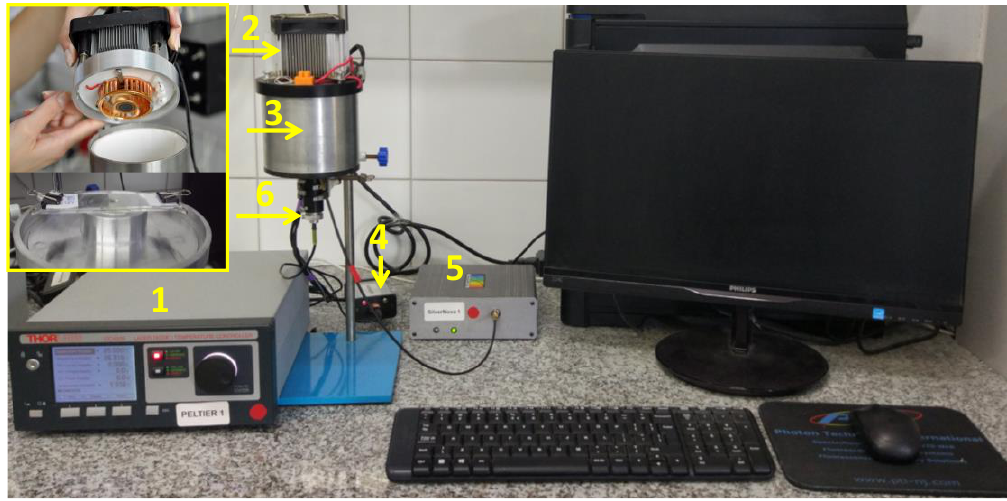
Figure 1. A stationary cure monitoring system was composed of a